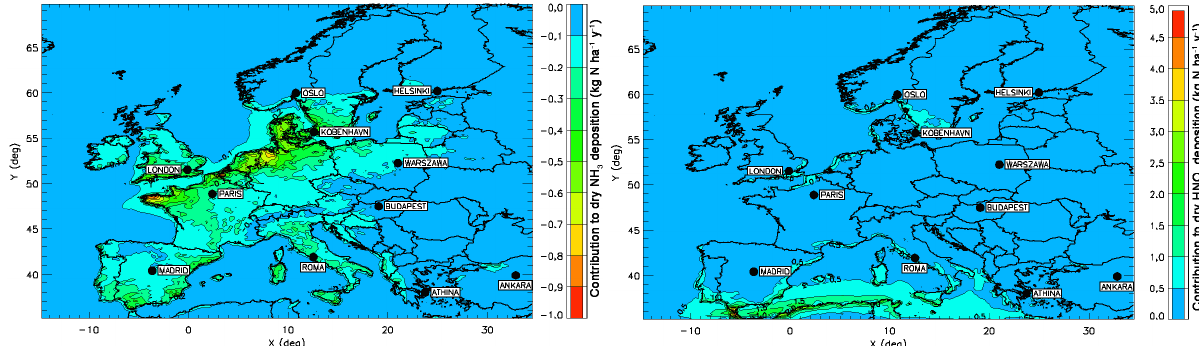
Figure 9. Contribution of ship emissions to the annual dry NH 3 deposition (left) and dry HNO 3 deposition (right) (base case − no ship).